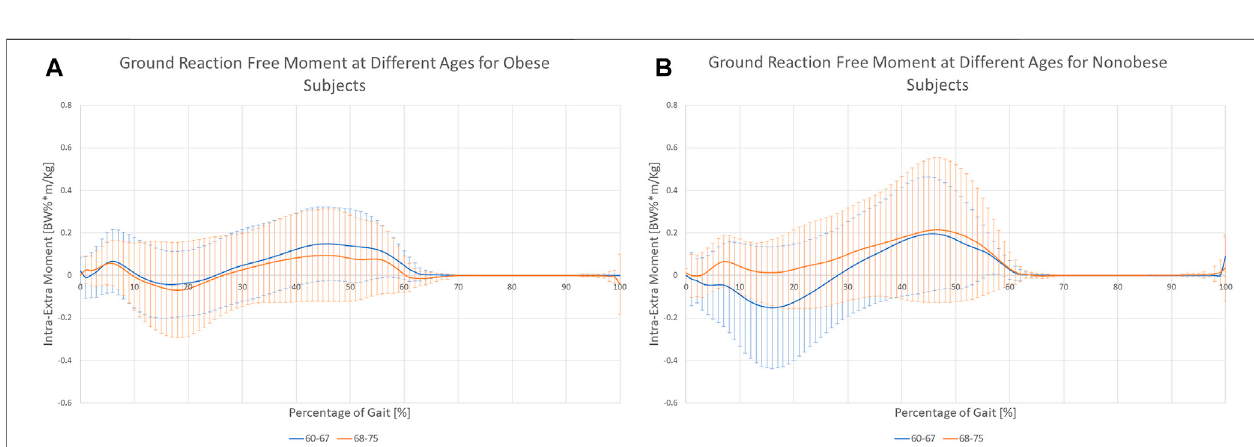
Frontiers in Bioengineering and Biotechnology |